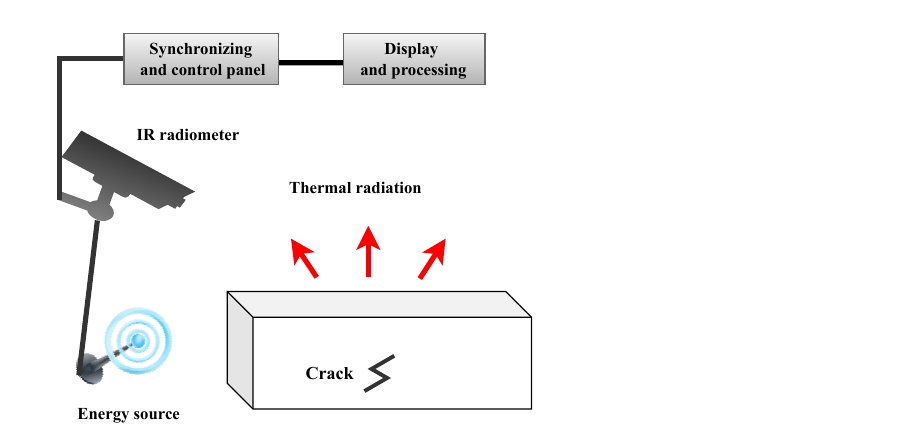
Figure 7. Schematic of the measurement principles of infrared thermography